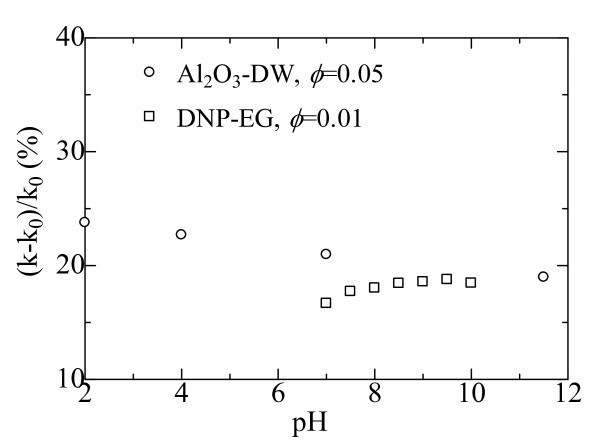
Thermal conductivity enhancement ratios at different pH values: Al2O3-DW [7]; DNP-EG [40].